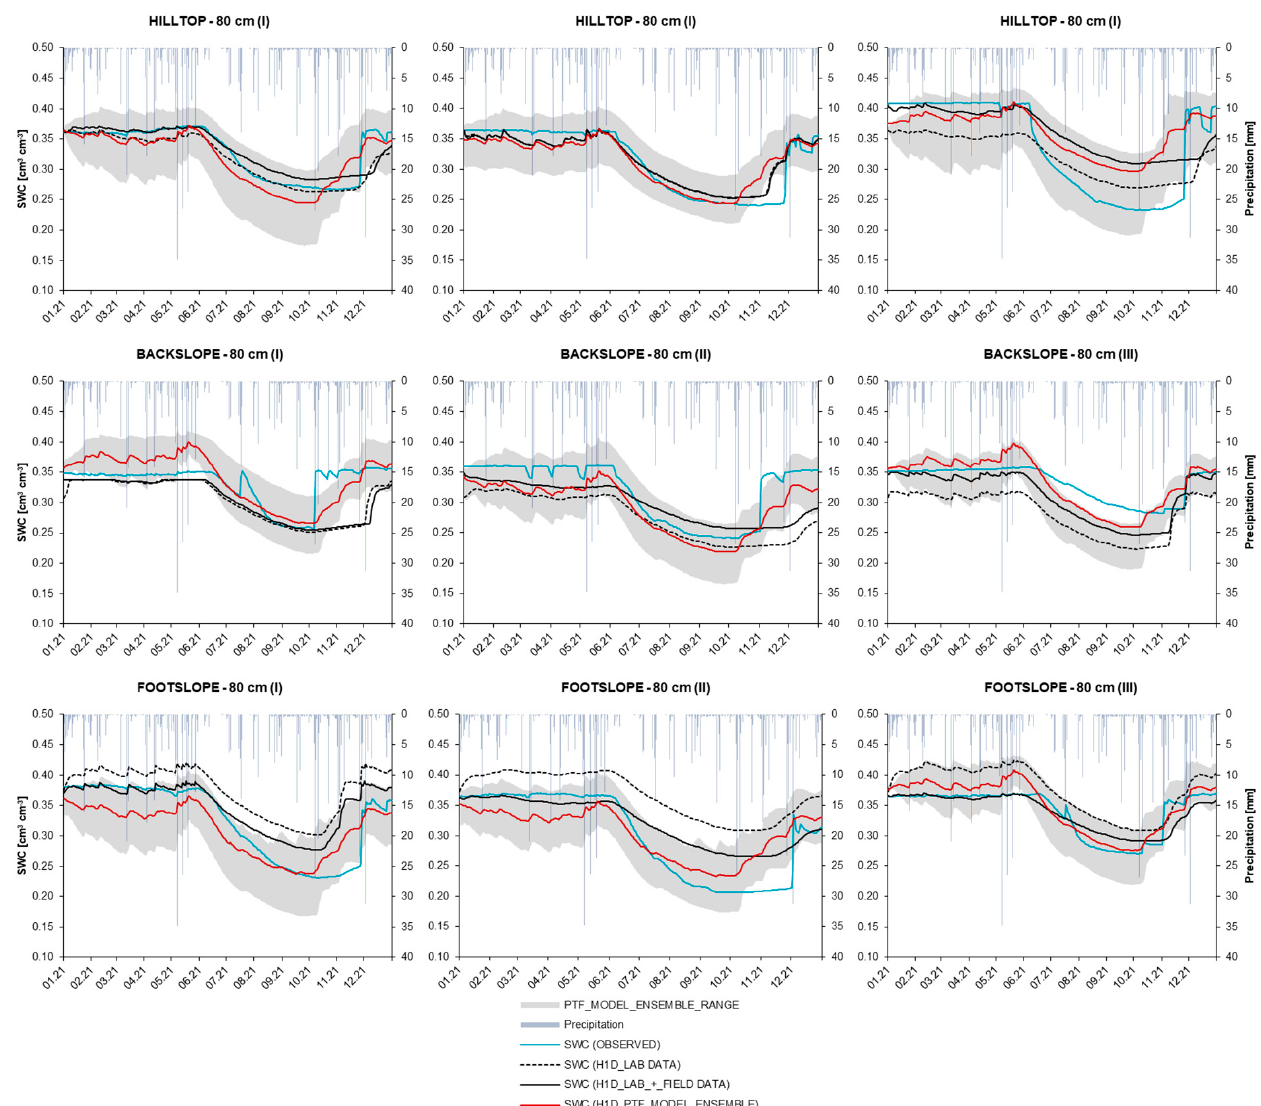
Figure 6. Simulated soil water content (SWC) [cm 3 cm − 3 ] in HYDRUS-1D: pedotransfer (PTF) model ensemble (red line), PTF model ensemble spread (5–95 percentile range) (grey area), laboratory dataset (dashed black line) and combination of lab and field data (black line), and field SWC measurements (blue line) in three vineyard rows at 40 cm depth, with precipitation data obtained with weighing lysimeter in 2021 at the SUPREHILL Critical Zone Observatory.